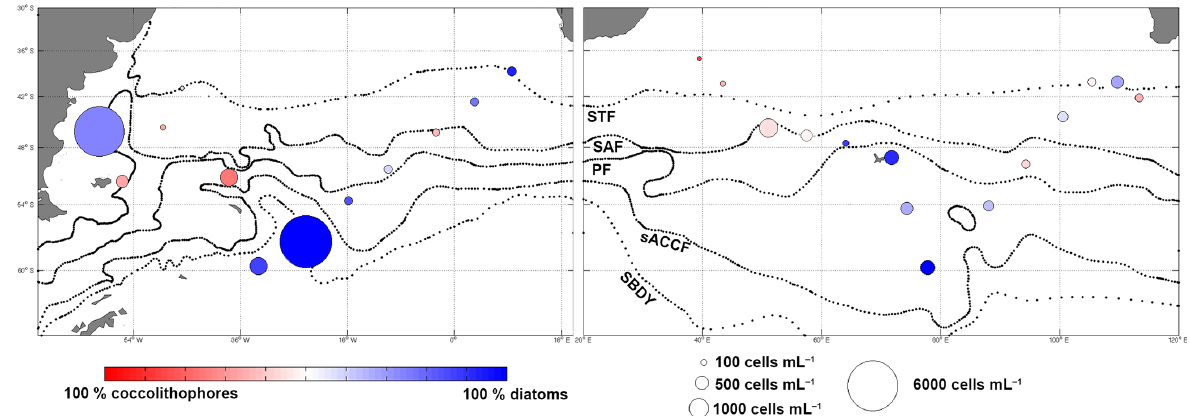
Figure 2. Coccolithophore and diatom abundance and dominance information. The area of the circles denotes abundance, while the shading denotes percentage contribution of each phytoplankton group; red denotes coccolithophore dominance and blue denotes diatom dominance. Fronts are defined as in Fig.